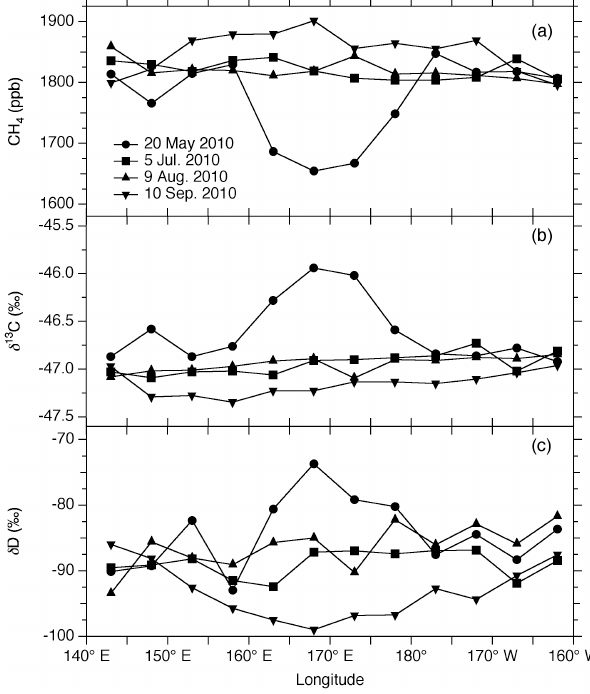
Figure 8. Longitudinal distributions of (a) the CH 4 mixing ratio, (b) δ 13 C and (c) δ D observed in four flights between Honolulu, Hawaii and Narita, Japan.